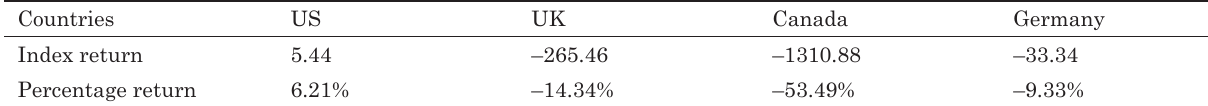
Table 7. The return of the securitized real estate indices of the four countries by holding one unit of each index throughout the whole period, with the presence of 0.5% buying cost